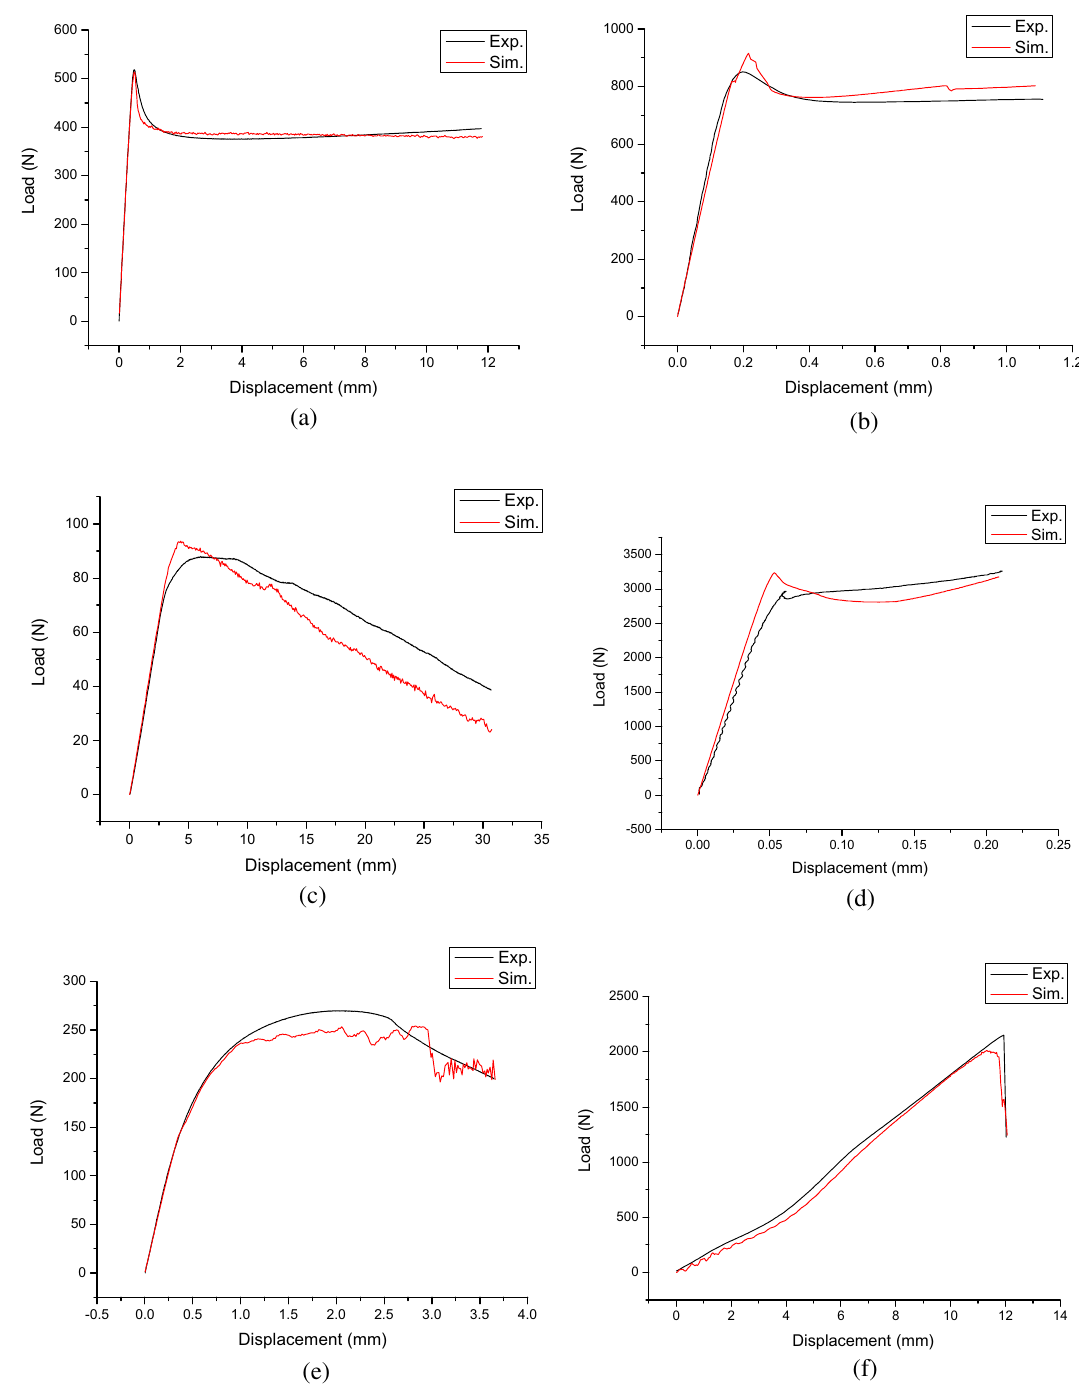
Figure 6. Experimental results in comparison to simulation results for ( a ) tensile test, ( b ) notched tensile test, ( c ) three-point bending test, ( d ) compression test, ( e ) grooved-shear test and ( f ) puncture